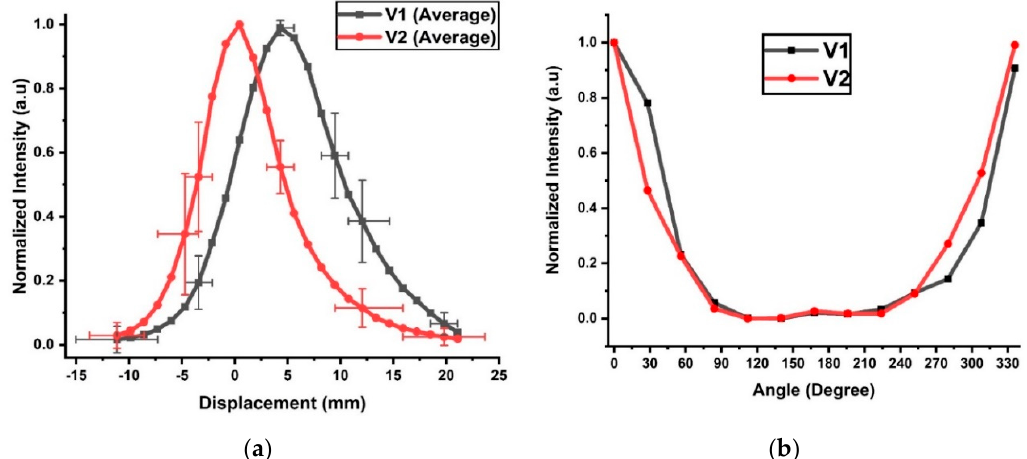
Figure 5. Normalized voltages measured by the two detectors V1 and V2 against the displacement ( a ) and rotation ( b ) of the ETT with a side-firing optic fiber.